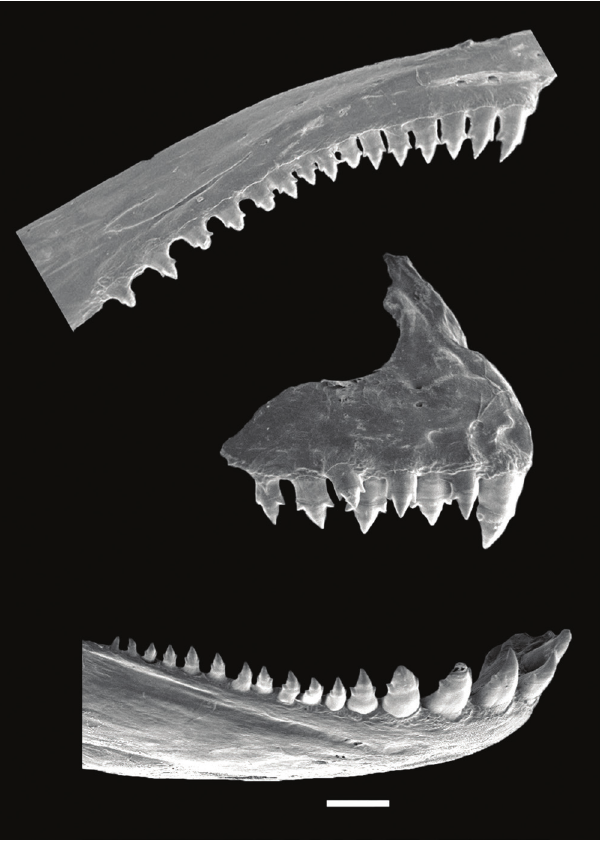
Fig. 5. Hollandichthys taramandahy , MCP 24621, paratype, 78.1 mm SL. Scanning electronic micrograph of the premaxilla (middle) and of toothed portion of maxilla (top) and dentary (bottom), right side. Scale bar = 1